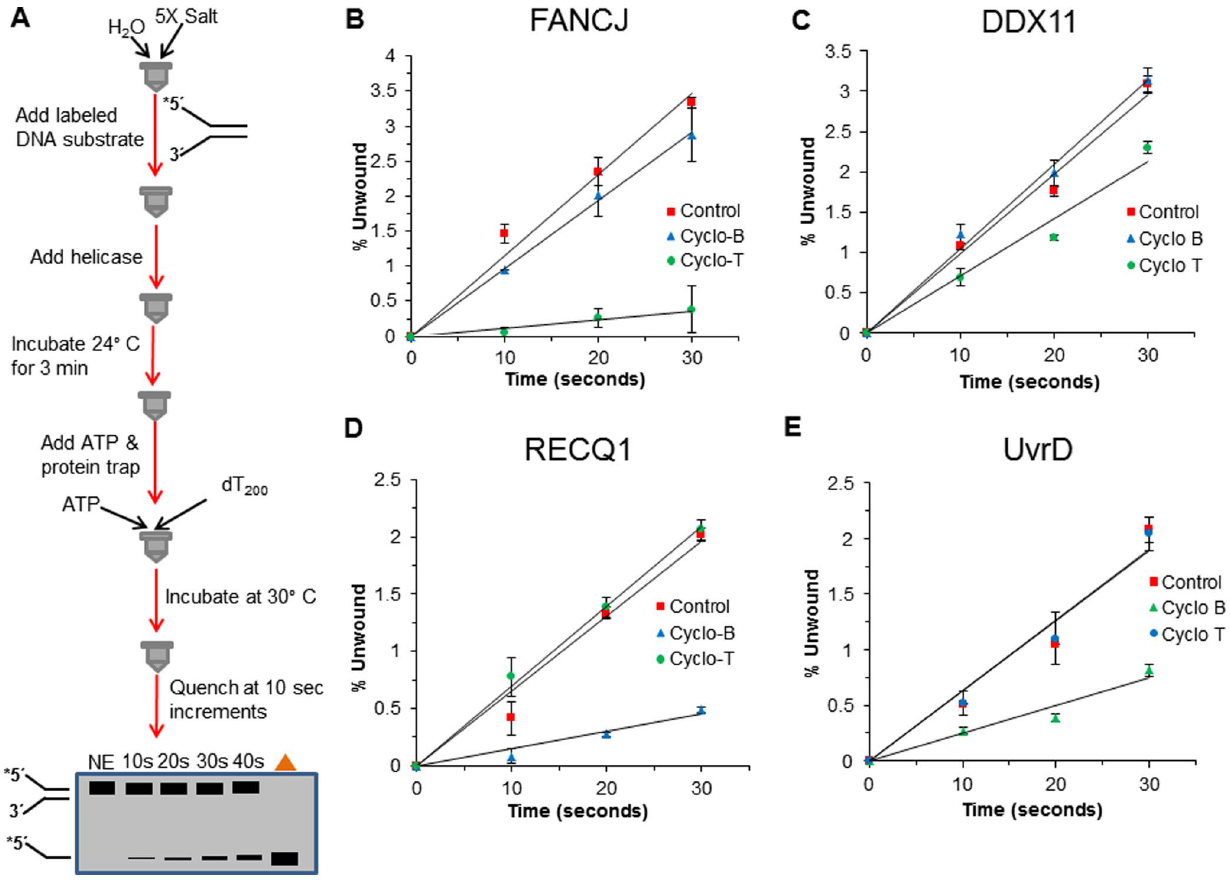
Figure 8. Protein trap kinetics assay to measure FANCJ, DDX11, RECQ1, and EcUvrD rates of unwinding DNA substrates with cyclo dA. Reactions were performed under protein trap kinetic assay kinetics conditions described in the Materials and Methods. A, Schematic of protein trap kinetics helicase assay. B , Quantification of FANCJ helicase activity on cdA DNA substrates. C , Quantification of DDX11 helicase activity on cdA DNA substrates. D, Quantification of RECQ1 helicase activity on cdA DNA substrates. E, Quantification of EcUvrD helicase activity on cdA DNA substrates.